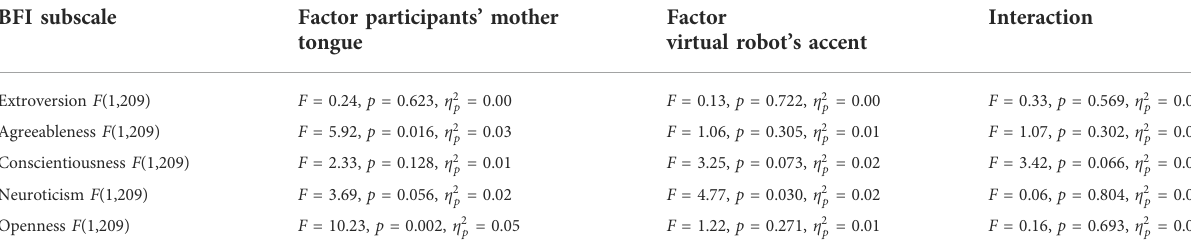
TABLE 2 Main effects and interactions for post-hoc analysis of the BFI scales.